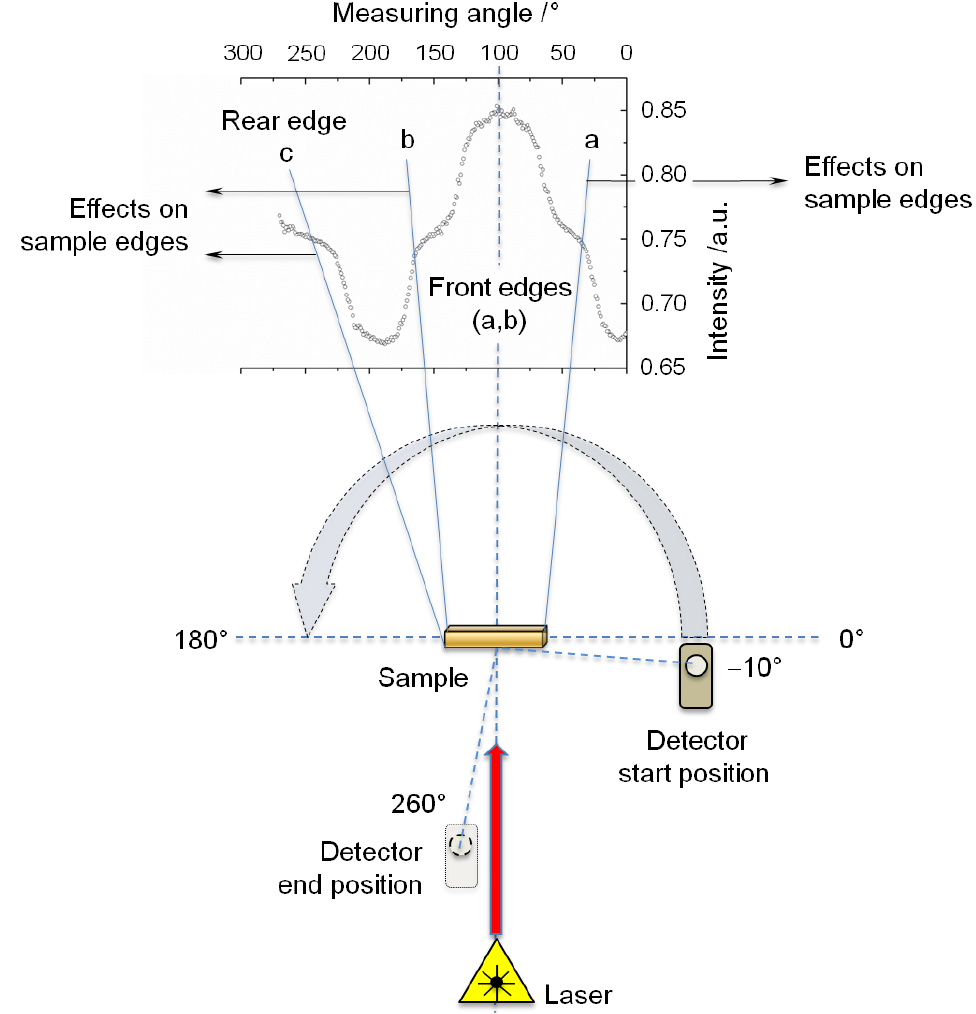
Figure 2. Illustration of the measurement principle for determining the line shapes and line widths Full Width at Half Maximum (FWHM). The diagram shows the intensity distribution of the transmitted light exemplified by the laser irradiation at 532 nm on a ceramic base model as a function of the measuring angle. The lines a, b, and c delineate edge effects which appear upon the interaction of the laser light with the base model.